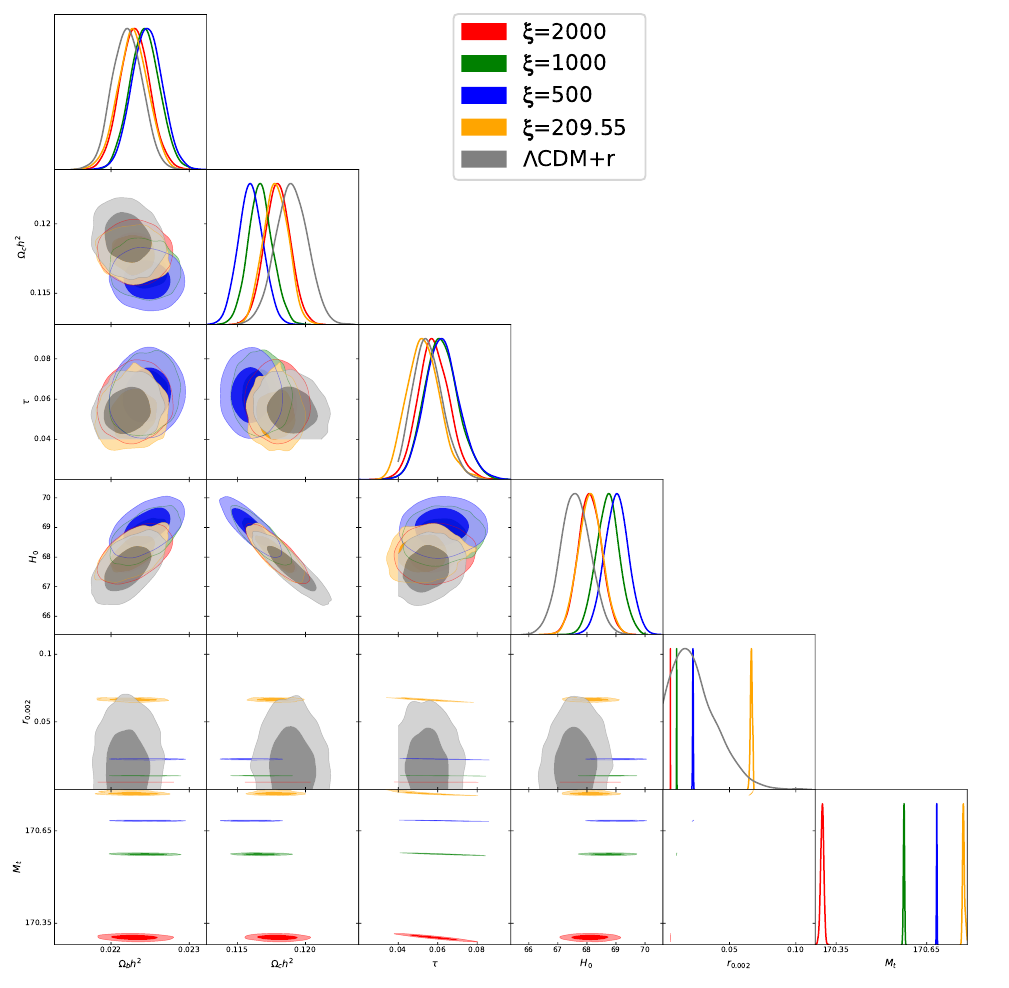
Figure 7 . 2D C.L. and posterior distributions of Higgs Inflation and Λ CDM+r